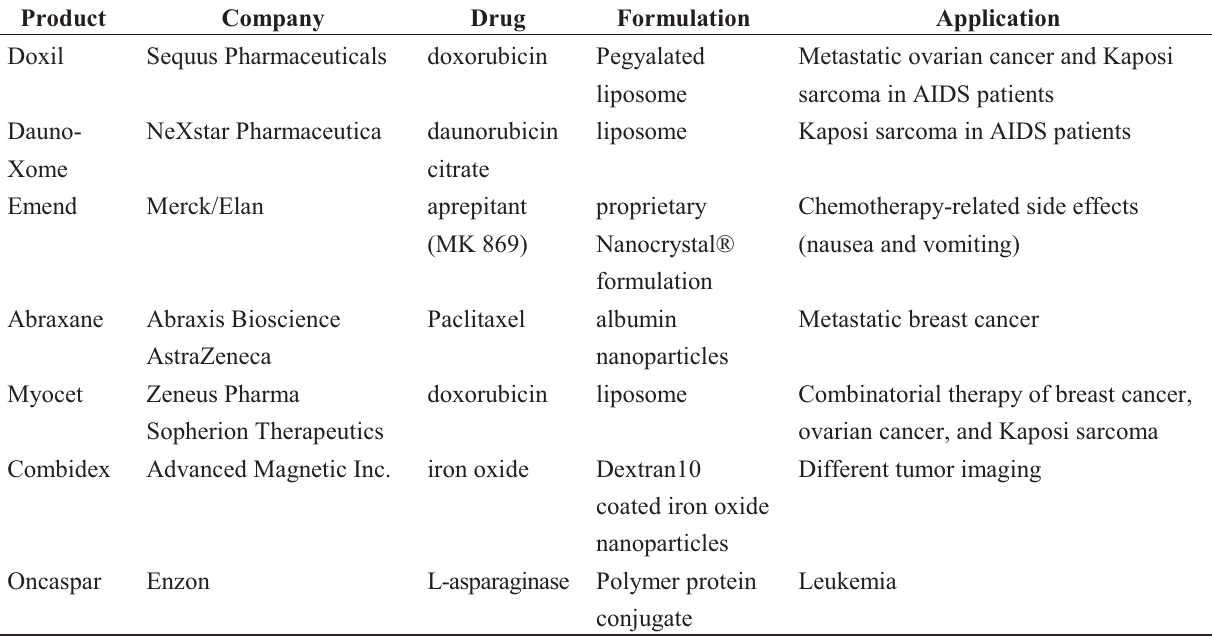
Table 1. Examples of nanocarrier-based drugs on the